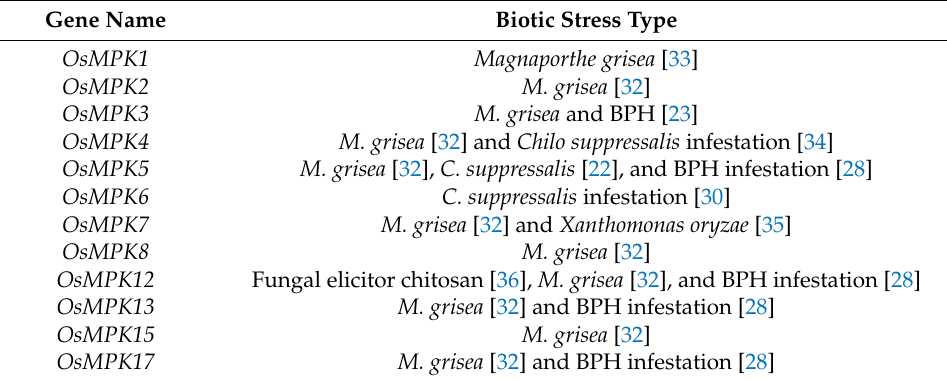
Table 1. Induced expression of OsMPK s under different biotic